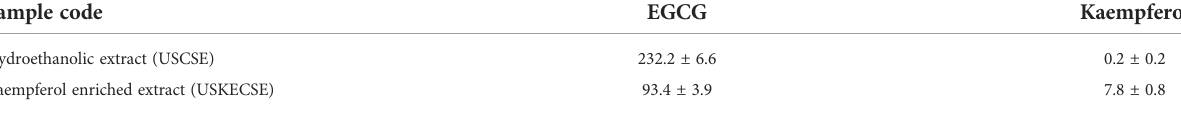
TABLE 2 Amount (mg/g) of target analytes in C. sinensis hydroethanolic extract (USCSE) and kaempferol enriched C. sinensis extract (USKECSE). Sample code